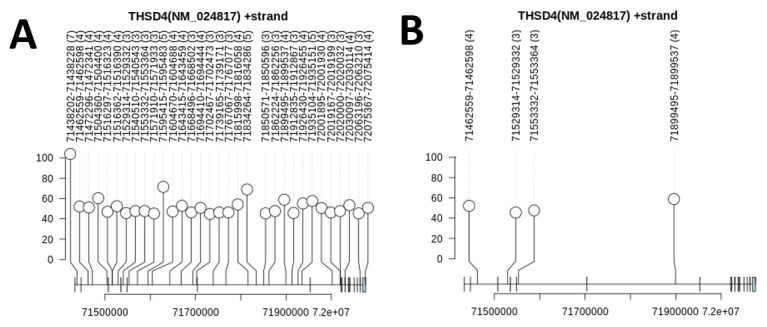
SRSF1 information dense clusters in the
THSD4 gene.
A) Lollipop plot of information density of clusters annotated by coordinate range and number of sites comprising that cluster using the SRSF1 “Replicate 2” information-based weight models (all
R
i ≥
R
sequence) for the NM_024817 mRNA splice form of
THSD4 (some clusters counted in Section 1 – Table 5 (extended data
39) are found in other
THSD4 splice forms which span beyond the range of this particular mRNA).
B) Information dense SRSF1 clusters within
THSD4 that overlap a DRIPc-seq interval (GSE70189 DRIPc-seq dataset). One additional overlapping cluster is not displayed, as is located immediately upstream of the 5’ untranslated region of the NM_024817.2 splice form. No intervals from the GSE68845 DRIP-seq dataset overlap this gene.